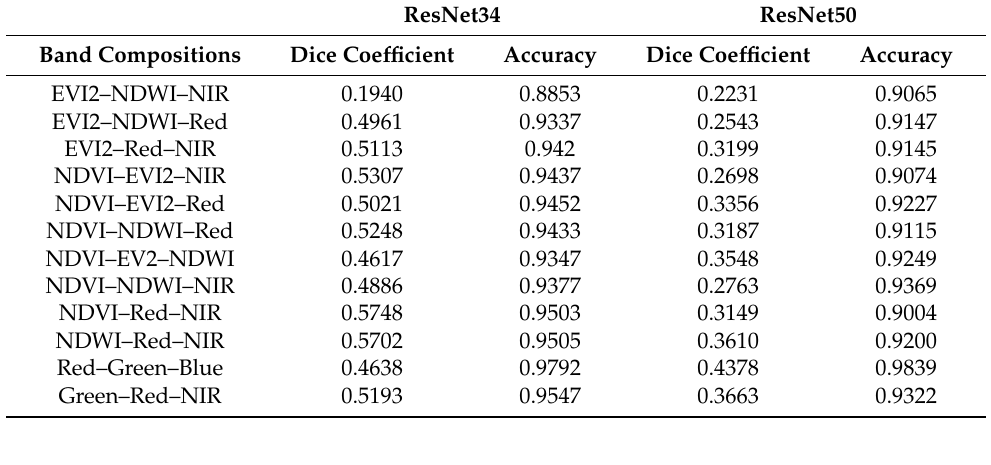
Table 3. Semantic segmentation model validation results for UGSs in VHR satellite images.